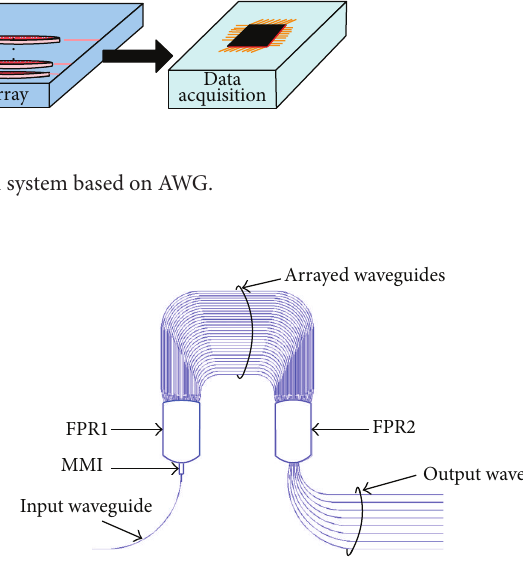
Figure 2: Schematic diagram of an